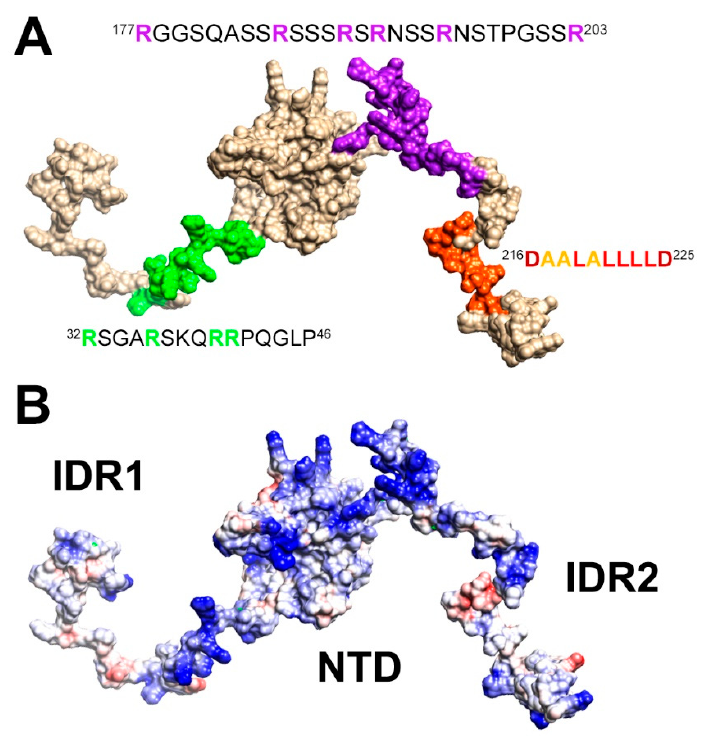
Figure 4. A cartoon of the NTR construct illustrating ( A ) the most perturbed regions upon the addition of RNA resulting from this study and ( B ) the large positive patch spanning both the IDRs and the globular domain. The two models were obtained as described in the experimental section.